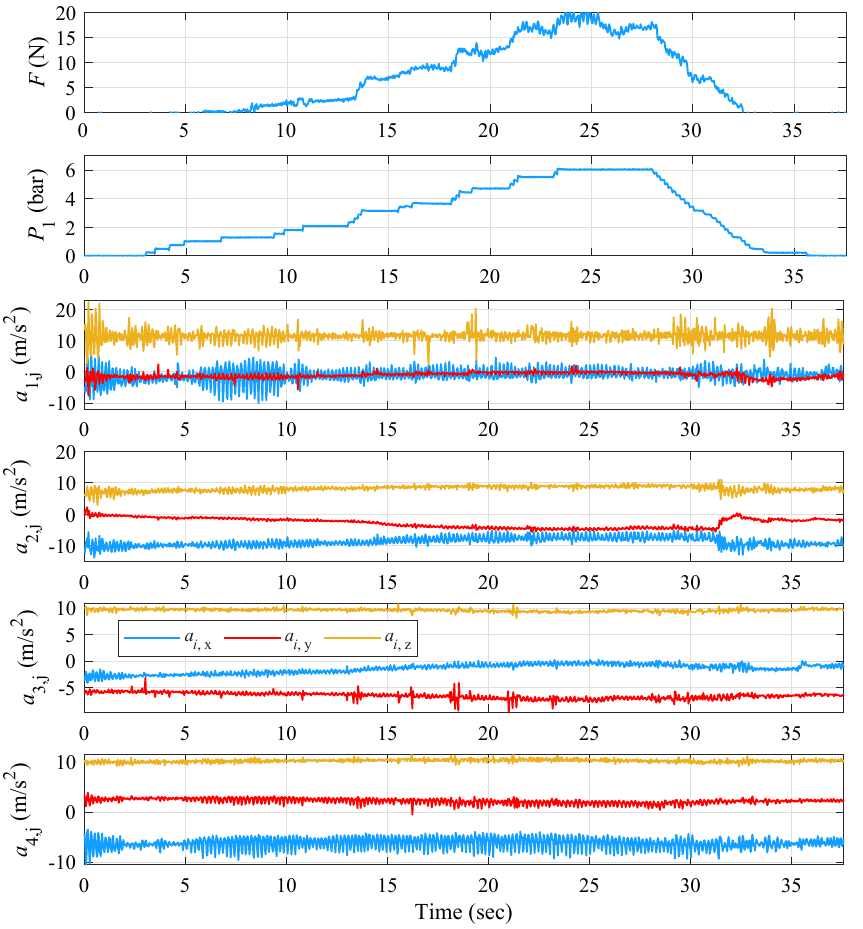
Figure 11. Experimental evaluation of iteration (A) and the effect of applying resisting force on the ET-diagnosed volunteer’s index-finger under open-loop changes in applied pressure and while the hand is at extended pose. Tremor translation circumstance; Exp. 3.